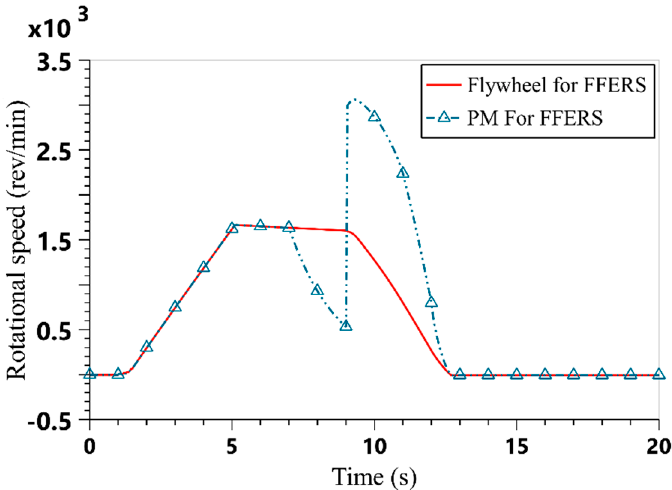
Figure 19. The rotational speeds of the flywheel and PM of the FFERS with a variable transmission ratio.